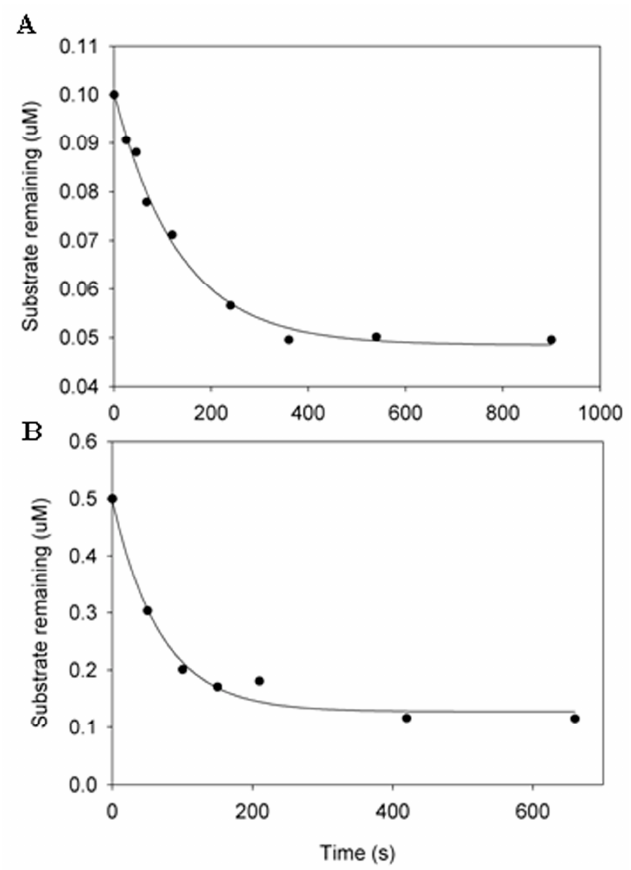
Figure 3. Pre-steady-state kinetic analysis of the cleavage of IKK ε by NS3/NS4A (5 μ M NS3 + 244 μ M NS4A) at 23 °C. The IKK ε concentration was 0.1 μ M ( A ) and 0.5 μ M ( B ). In each time course, the concentration of remaining IKK ε was plotted against time. The data were fit to Equation (1) (see Experimental Procedures) to yield 0.0075 and 0.0145 s − 1 for the observed cleavage rate constants in ( A ) and ( B ), respectively.